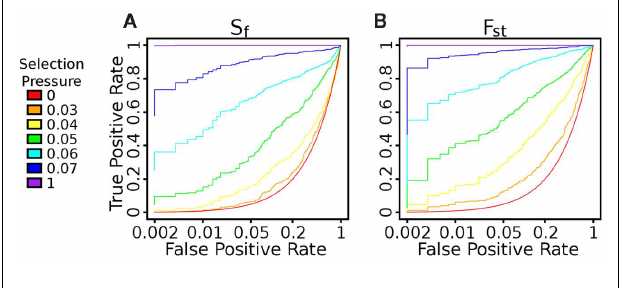
FIGUREA3 | ROC Curve evaluating the impact of threshold on true positive and false positive rates. Using F st leads to better performance than using S f in this regime. For instance, at s = 0.05, with a 5% false positive rate, we can detect 33.8% of the true positives with S f and 61.4% with F st .